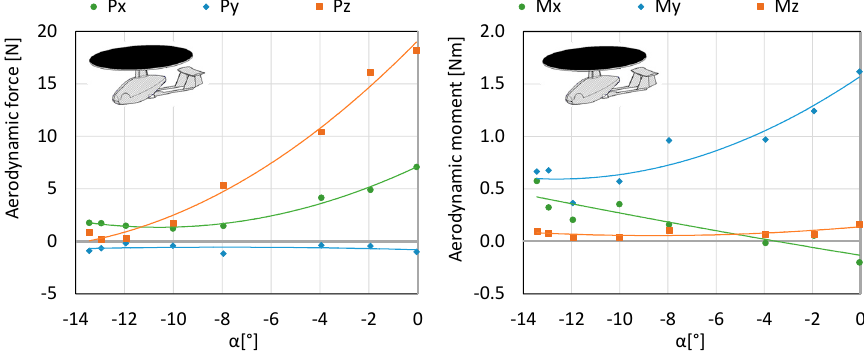
Figure 7. The characteristics of coefficients of forces and aerodynamic moment for configuration K2.